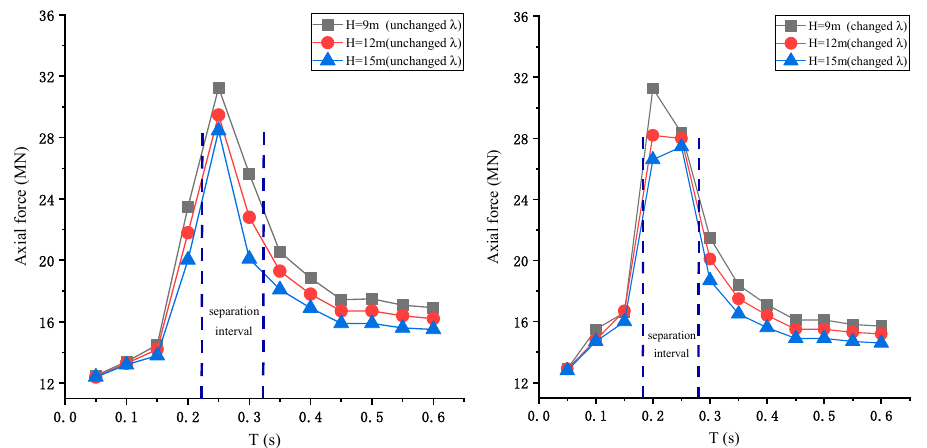
Figure 10. Various bending moments and allowable bending moments at the pier bottom: ( left ) Changes of various bending moments at the bottom of the pier at three extra heights; ( right ) Lon- gitudinal relative displacement of pier beam under extra pier height.